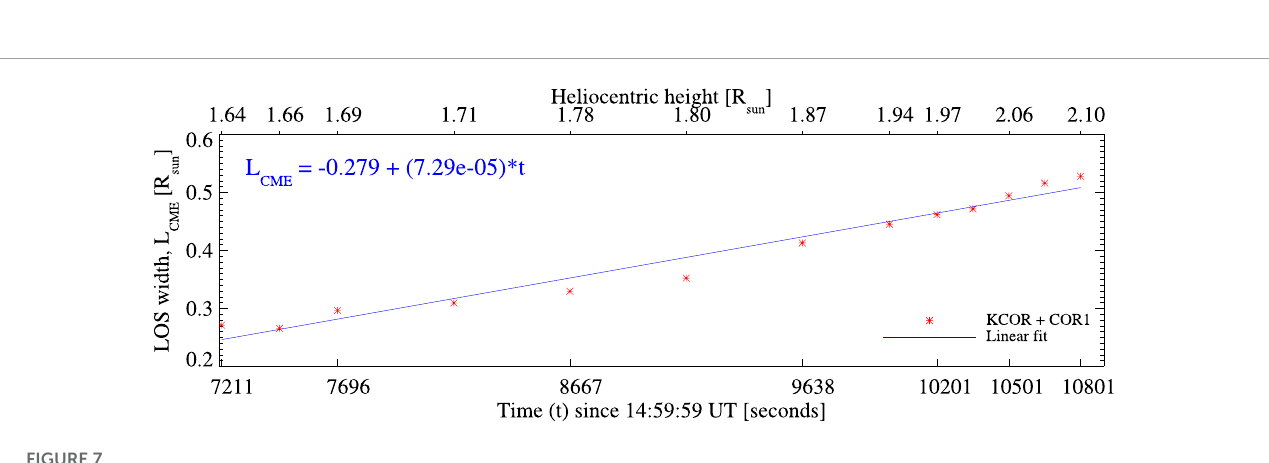
Frontiers in Astronomy and Space Sciences